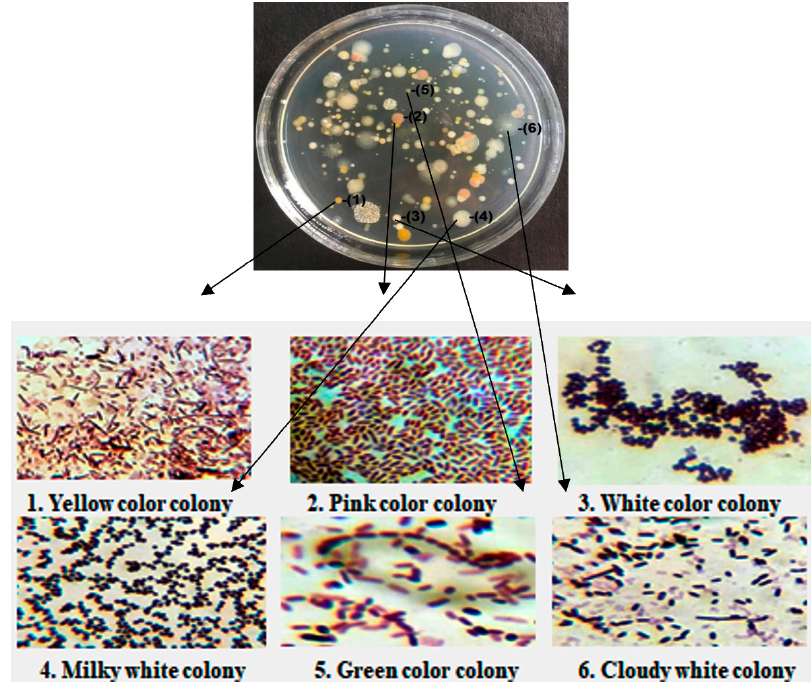
Fig. 1. Representing bacterial colony and microscopic